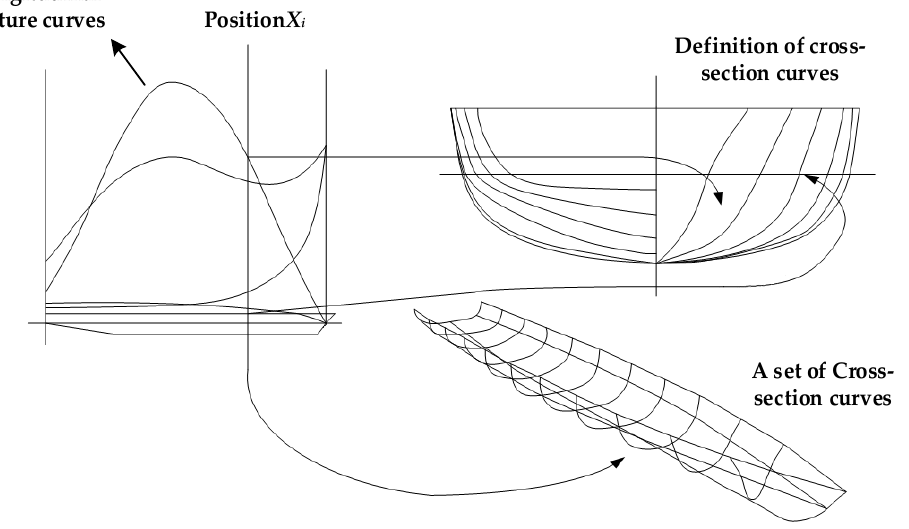
Figure 2. Definition of rules in the parametric ship design process.